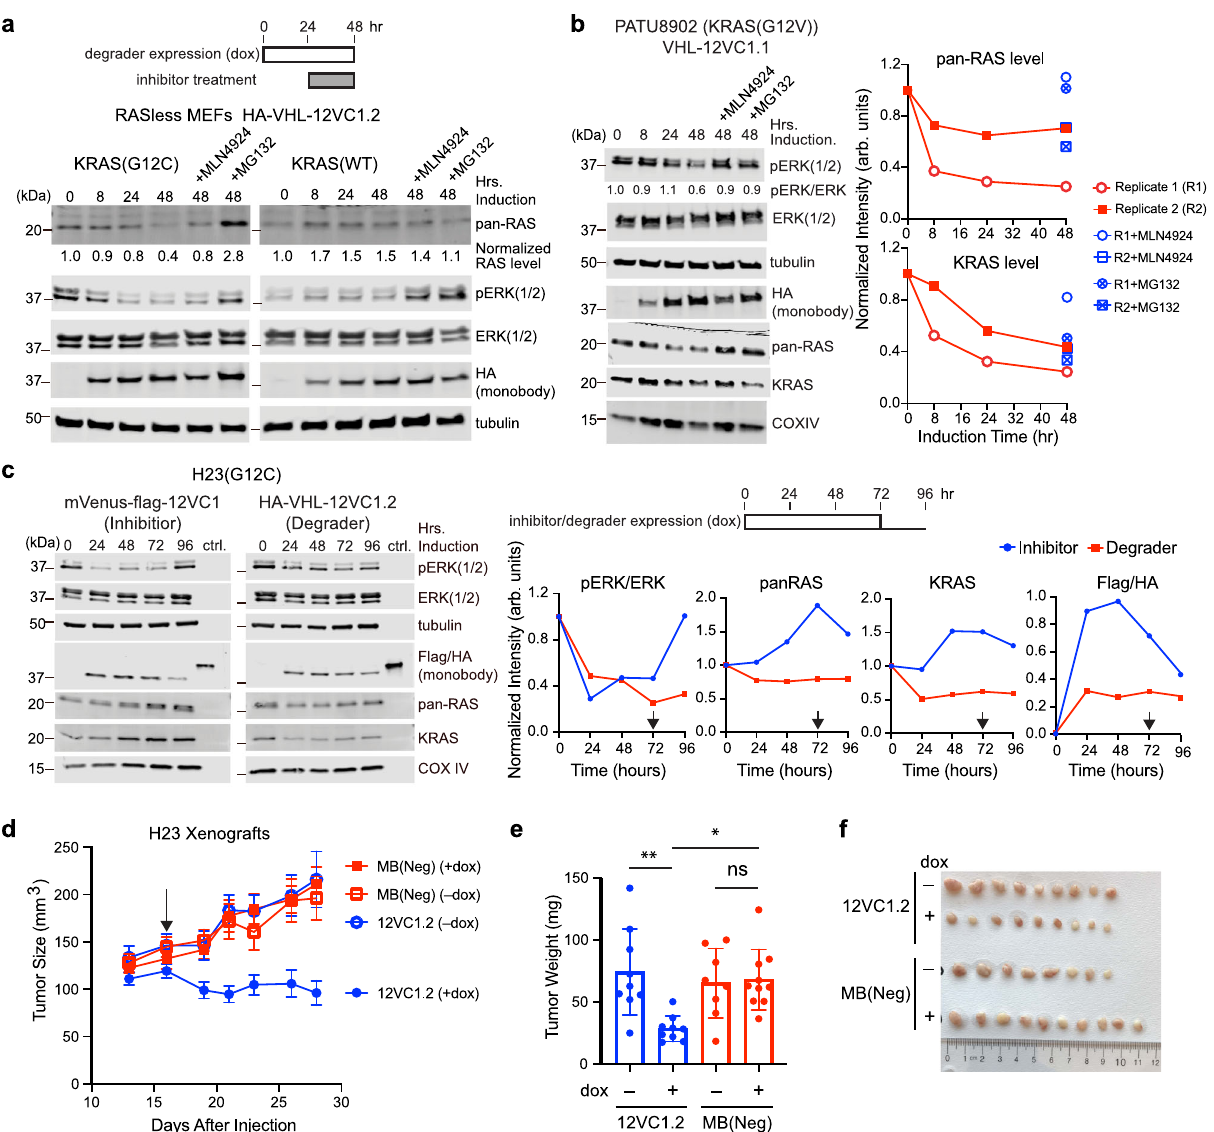
Fig. 4 Selective degradation of RAS mutants with a VHL – monobody fusion protein. a The time courses of the KRAS(G12C) and KRAS(WT) levels and the pERK level in RASless MEFs after the induction of the expression of the VHL – 12VC1.2 degrader. MLN4924 (1 µ M) or MG132 (5 µ M) were added after 24 h of degrader expression for an additional 24 h (see the scheme). Total RAS was quanti fi ed and normalized relative to t = 0. b Degradation of endogenous KRAS(G12V) by a monobody degrader and its effect on the pERK level in PATU8902. The experimental schematic was identical to that for ( a ). The graphs show the quanti fi cation of the total RAS levels and KRAS levels from immunoblots (biological replicates, n = 2). c The time courses of the RAS levels and pERK level after the expression of a monobody inhibitor (blue) or a degrader (red) in the H23 cells (biological replicates, n = 3, representative results shown). A Flag-tagged mVenus – 12VC1 fusion (inhibitor) and a HA-tagged VHL – 12VC1.2 fusion (degrader) were expressed upon addition of doxycycline (1 µ g/mL). The expression levels of the inhibitor or degrader were quanti fi ed using known amount of protein containing both Flag and HA tags (ctrl) as references. After 72 h of induction (black arrow), the media were replaced with serum- and doxycycline-free media to examine the persistent effects of intracellular inhibitors or degraders. d Mouse xenograft experiments with the H23 cell line expressing the VHL – monobody fusion proteins. Mice (5 per group for 12VC1.2 and MB(Neg) + dox, 4 per group for MB(Neg) − dox) were subcutaneously injected at the right and left fl anks with H23 cell lines that express either fusion protein under a dox-inducible promotor, with the exception of one mouse in the 12VC1 group that was injected only at the right fl ank with tumor cells. One group of mice per cell line was given dox-containing feeds when the average tumor size was above 100 mm 3 (black arrow) through the end of the experiment. The sizes of the tumors in MB(Neg) group (red squares) and 12VC1.2 group (blue circles) with (solid symbols) and without (empty symbols) dox feeds are plotted (mean ± SEM) as a function of time after cell injection. e Tumors were extracted at the end of experiment and their weights were compared ( n = 8 and 10 for tumors for MB(Neg) without and with dox, respectively, and n = 9 tumors for 12VC1.2, two-way ANOVA, 12VC1.2 − dox vs + dox, p -value = 0.004, 12VC1.2 + dox vs MB(Neg) + dox, p -value = 0.01, MB(Neg) + dox vs − dox, p -value > 0.99). The bar centers show the average tumor weights of the population and the error bars show SD. f An image of extracted tumors from each group with a ruler for scale, ranked from large to small in weight.